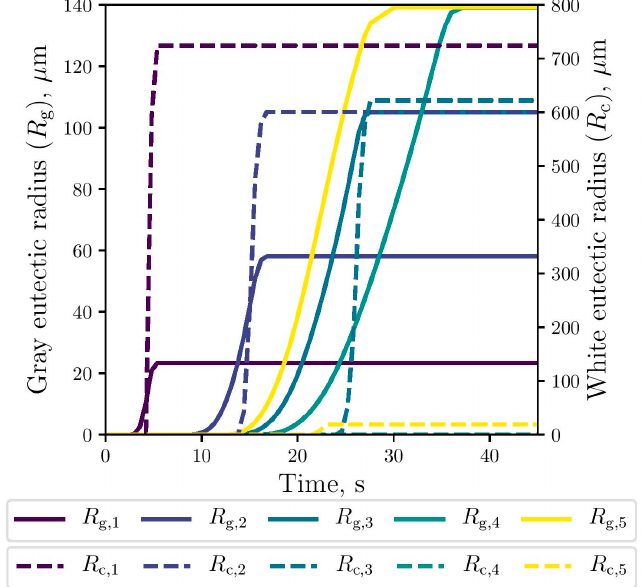
Figure 10. Simulated gray (continuous lines) and white (dashed lines) eutectic radii evolution at the selected points.